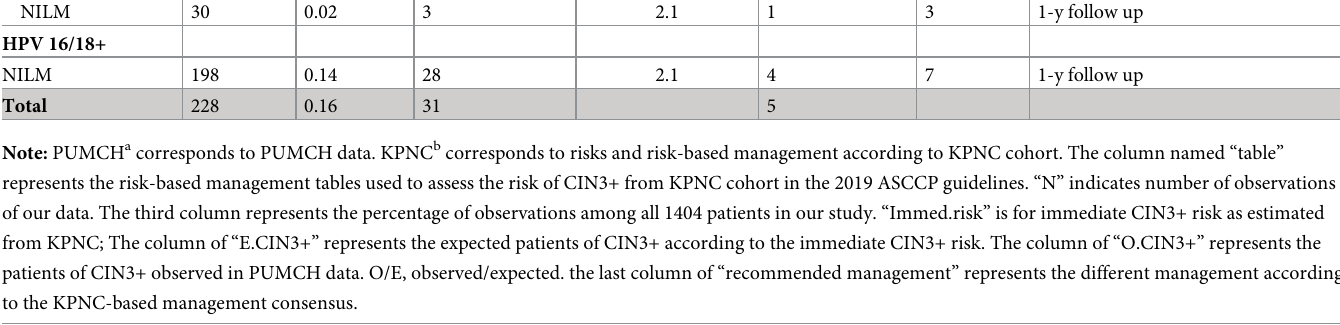
Table 7. Portability of KPNC risks and risk-based management for specific scenario of HPV+ NILM to the PUMCH data.